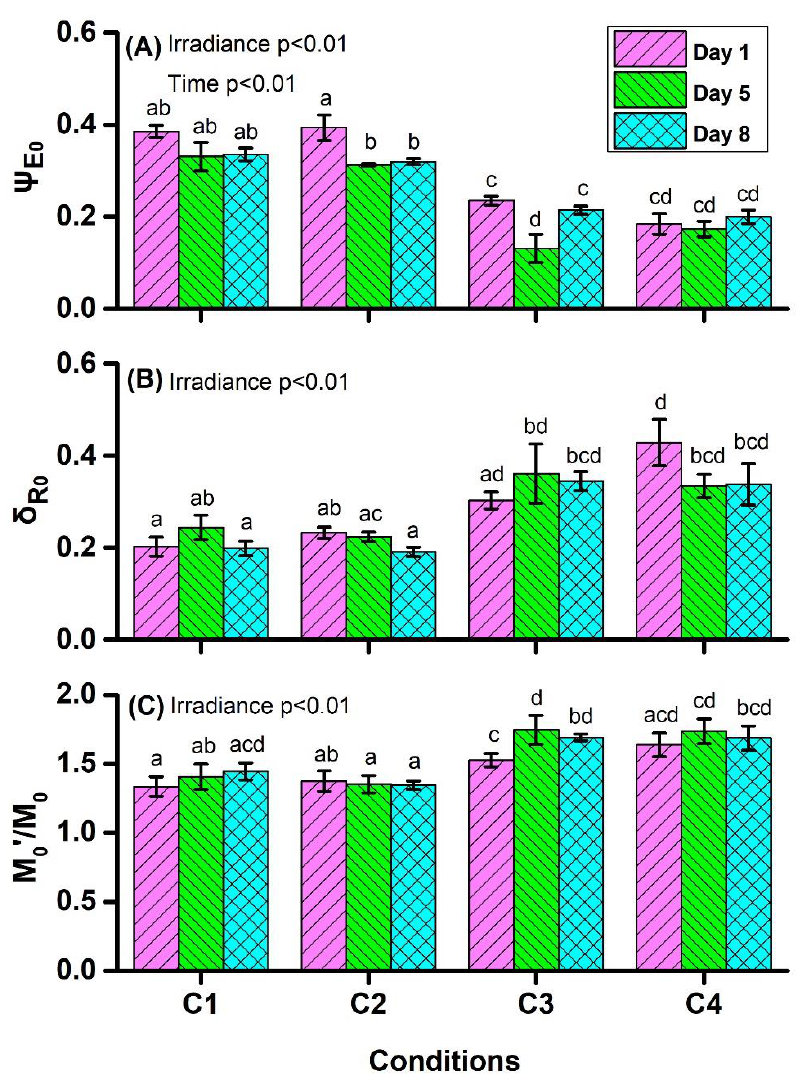
Figure 4. Effects of salinity and irradiance on ( A ) ψ E0 , ( B ) δ R0 , and ( C ) M 0 ’/M 0 . Values are means ± standard error, n = 6. For further information see Table 1 and Figure 2.